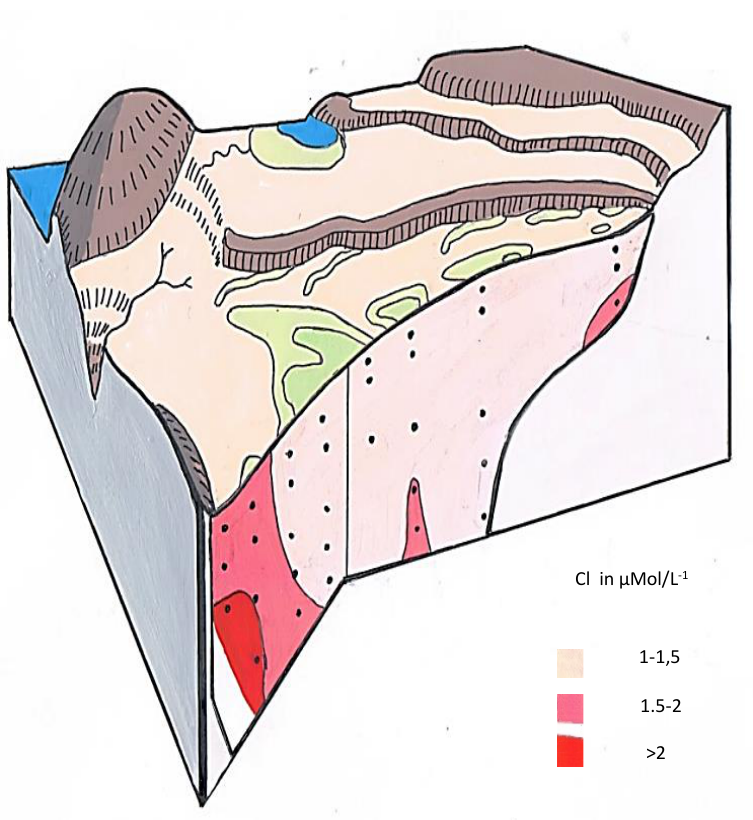
Figure 9. Chloride contents (µmol L -1 ) of pore water in peat profiles on Transects I and II.